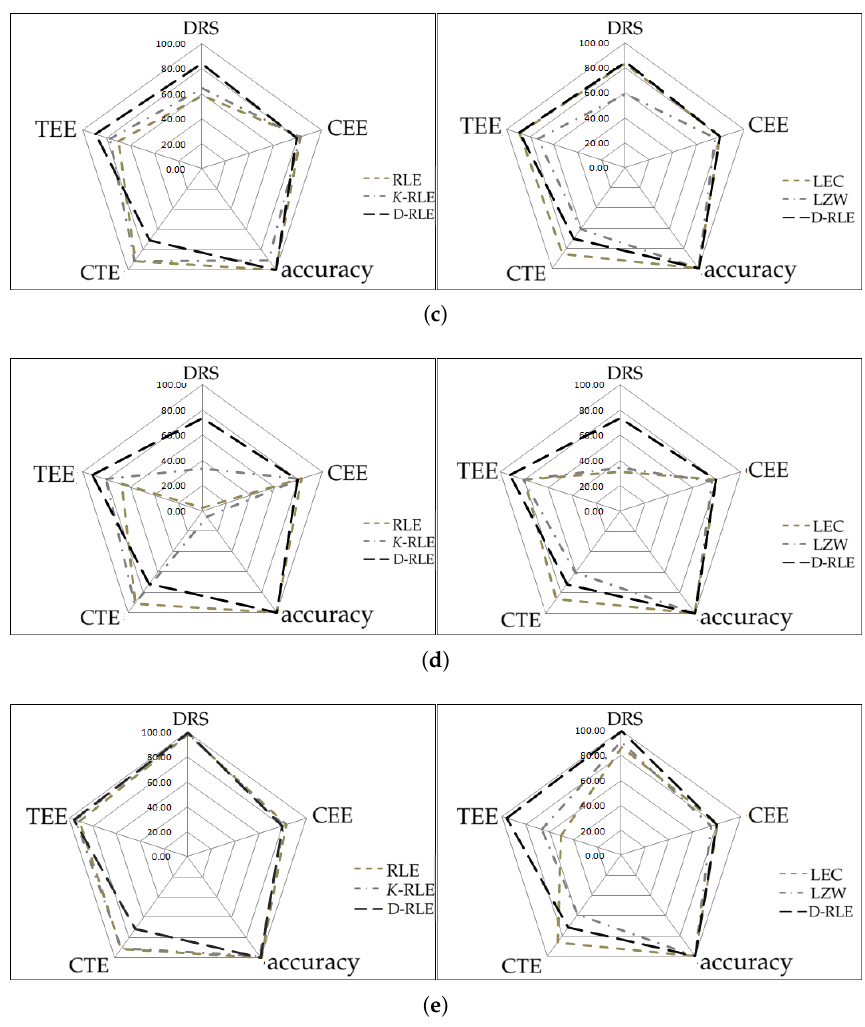
Figure 5. Radar chart comparison. ( a ) sine-like; ( b ) chaotic; ( c ) simulated temperature; ( d ) temperatureHr; ( e )